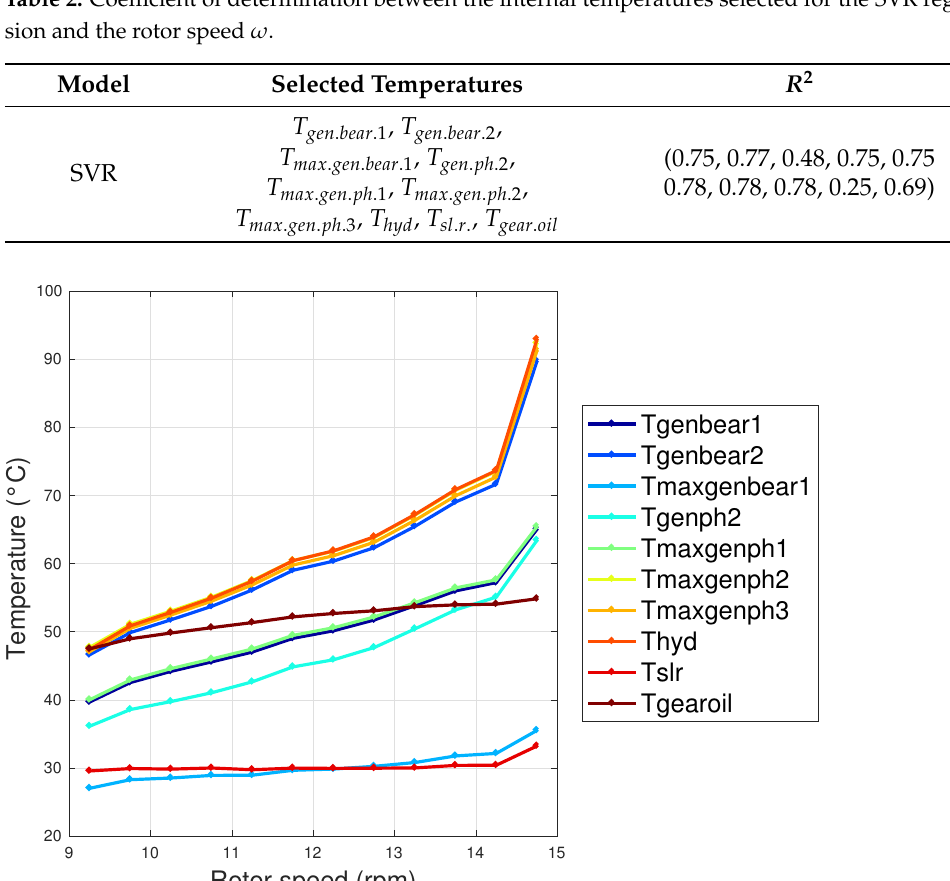
Figure 2. Average curve of the internal temperatures selected by the SVR regression as a function of the rotor speed ω